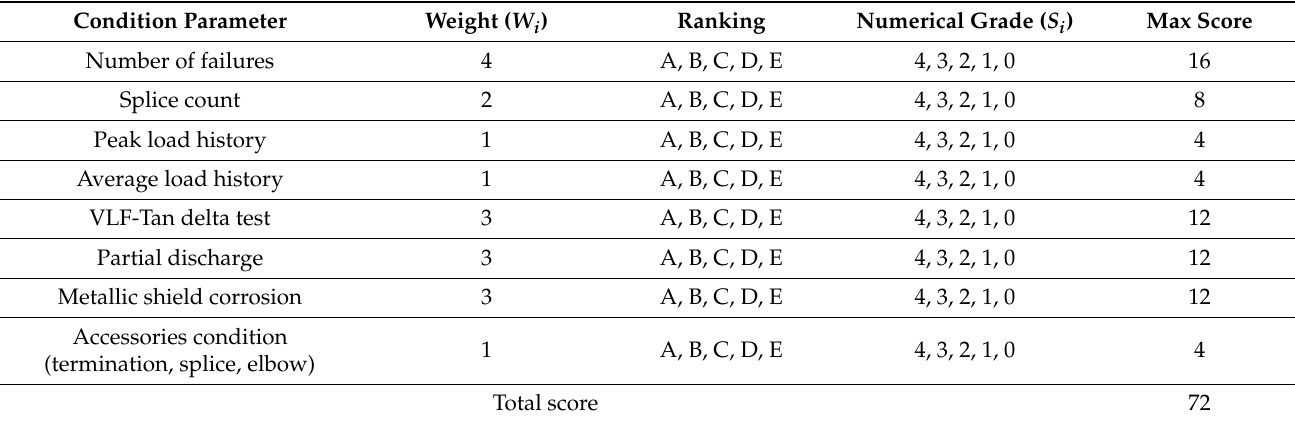
Table 2. Typical underground cable HI